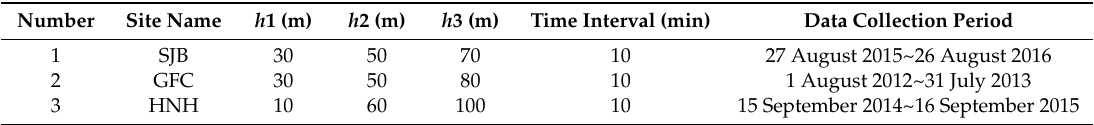
Table 6. Summary of measurement parameters.